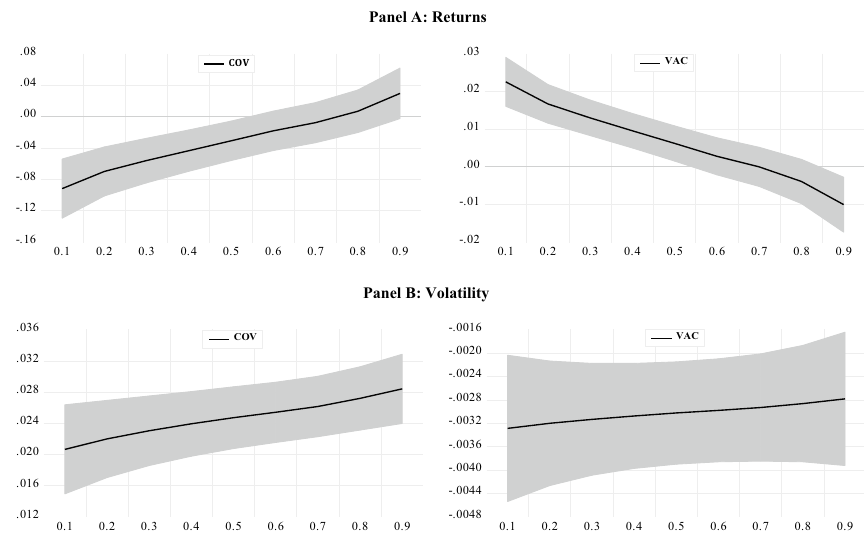
Fig. 2 Impact of positive and negative investor sentiments on returns and volatility. Note The shaded areas are two standard deviation confidence intervals